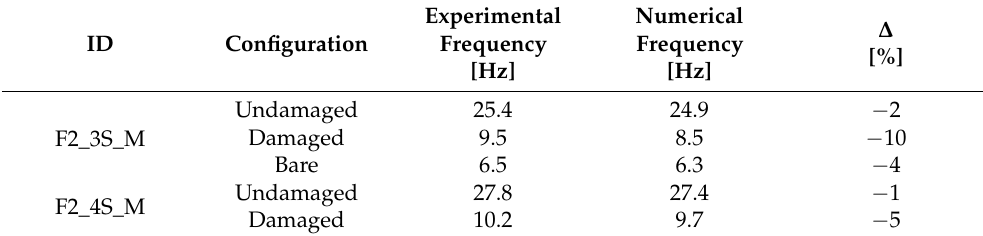
Table 9. Comparison of numerical and experimental frequencies for the in-plane vibration